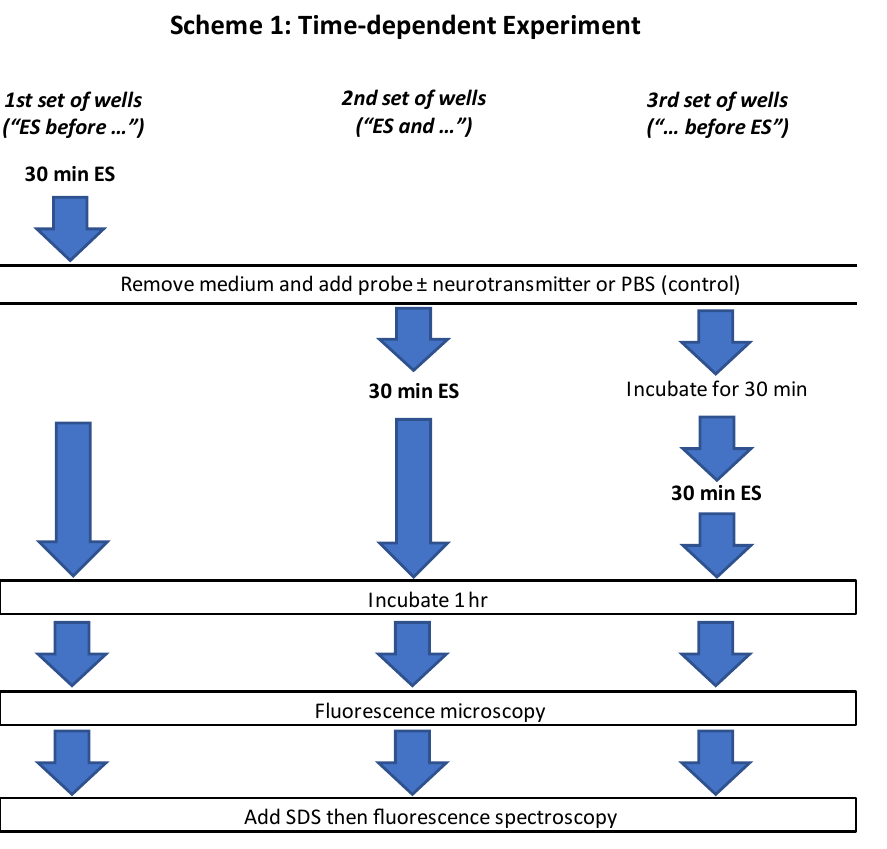
Figure 1. Time dependent experimental design varying the time of ES and neurotransmitter intro- duction. ES: electrical stimulation; PBS: phosphate buffered saline; SDS: sulfate dodecyl sodium.